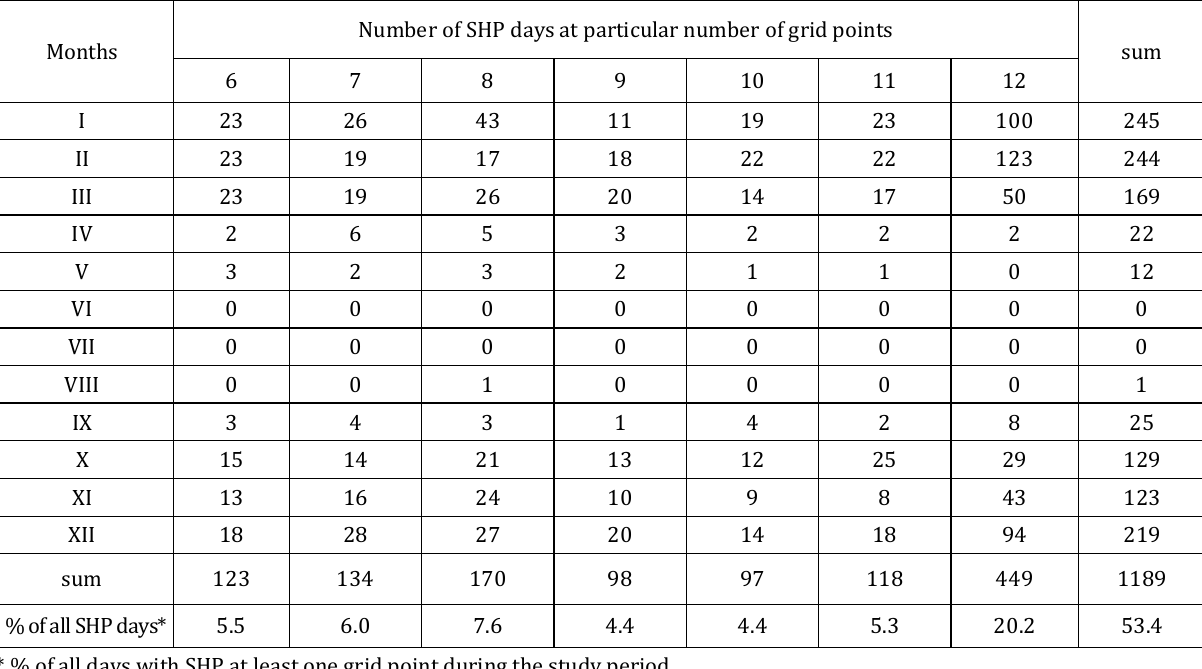
Table 4. Number of days with air pressure equal to or higher than 1030 hPa (SHP days) at particular grid points in the period 1951-2015